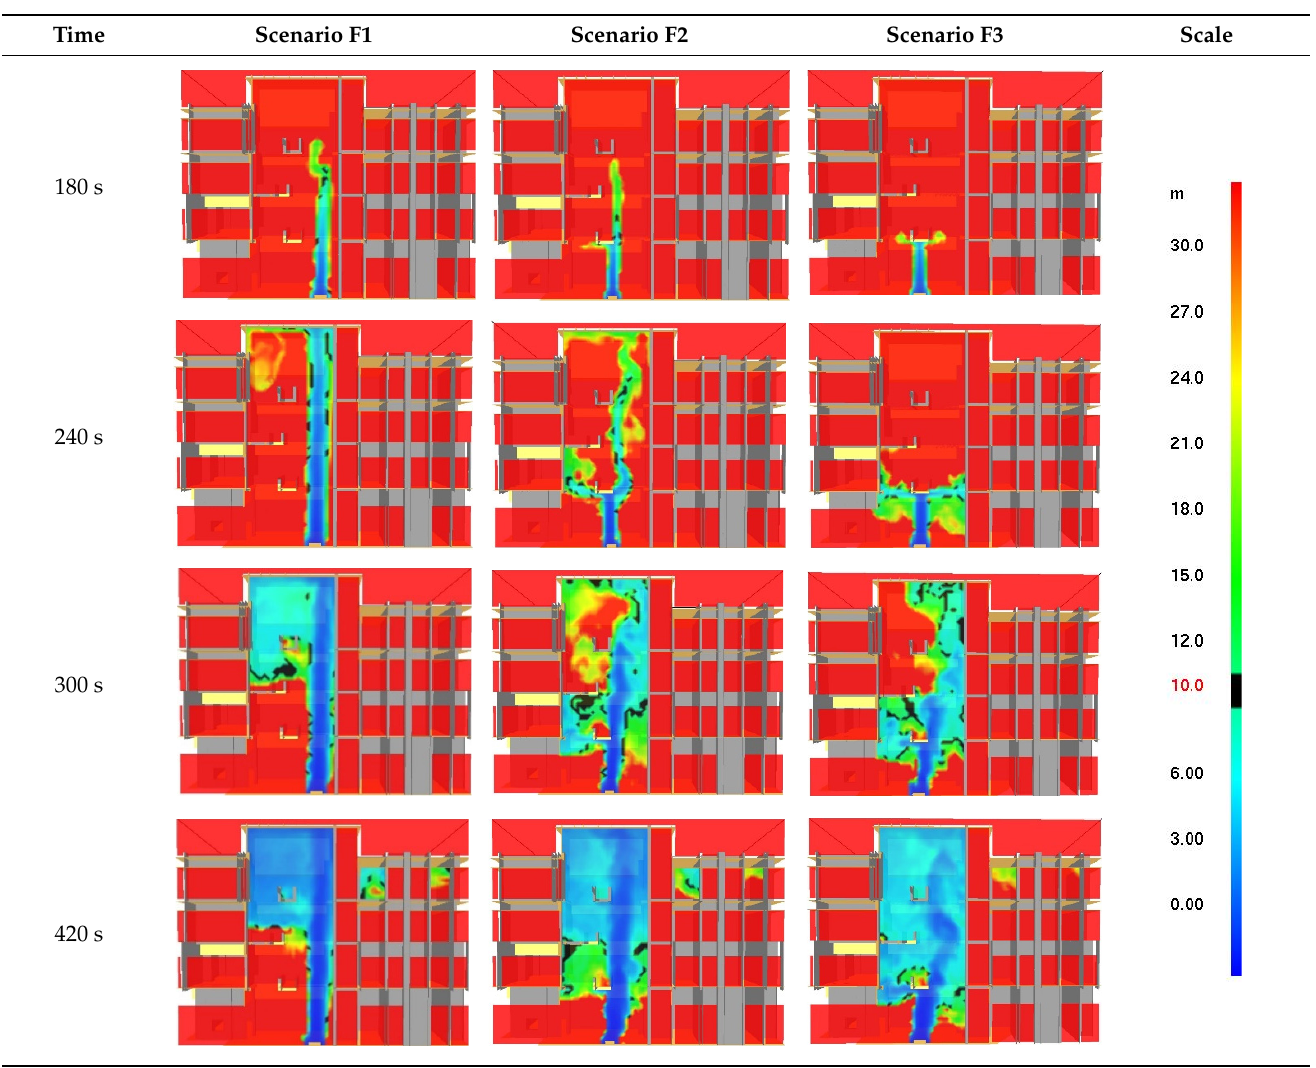
Table 2. Visibility in the cross-section of the atrium.